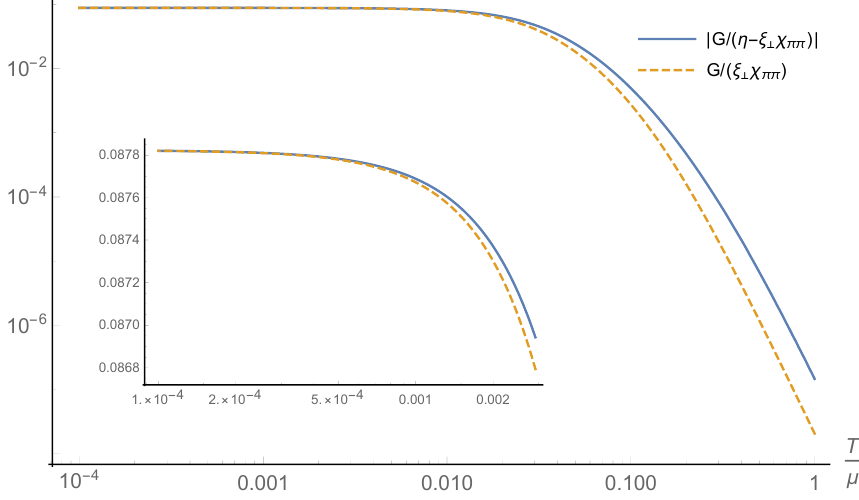
Figure 6 . At low temperatures, the gap at large wavevector is dominated by the phonon di(cid:11)usivity (cid:24) ? rather than by the shear viscosity (cid:17)